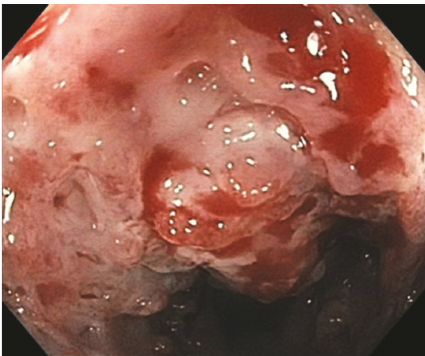
Figure 3: Colonoscopy image showing circumferential friable ulcerated mucosa in the descending colon.